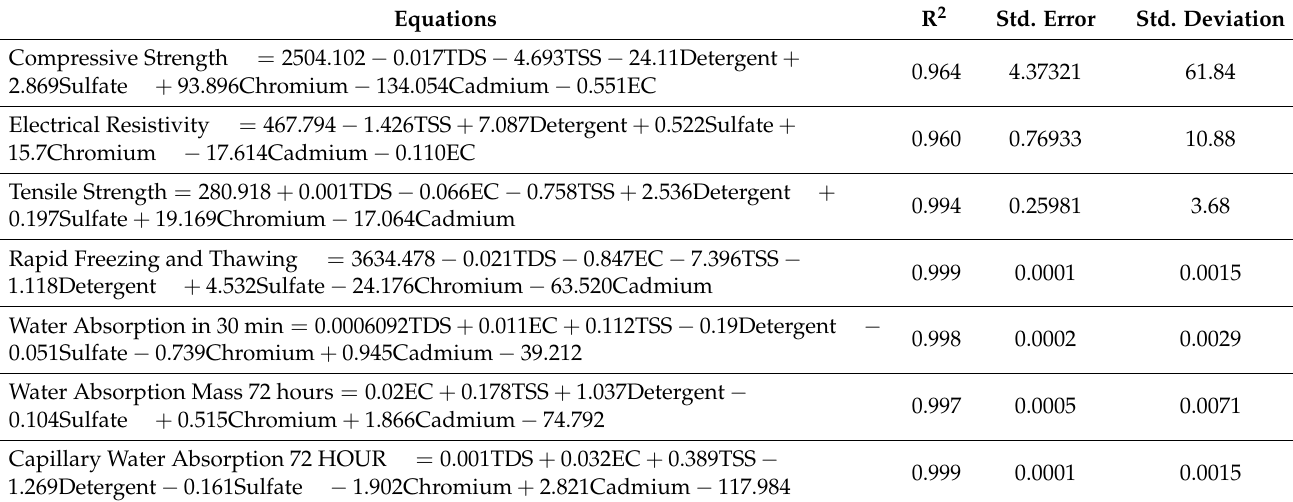
Table 12. Prediction models for determining characteristics of